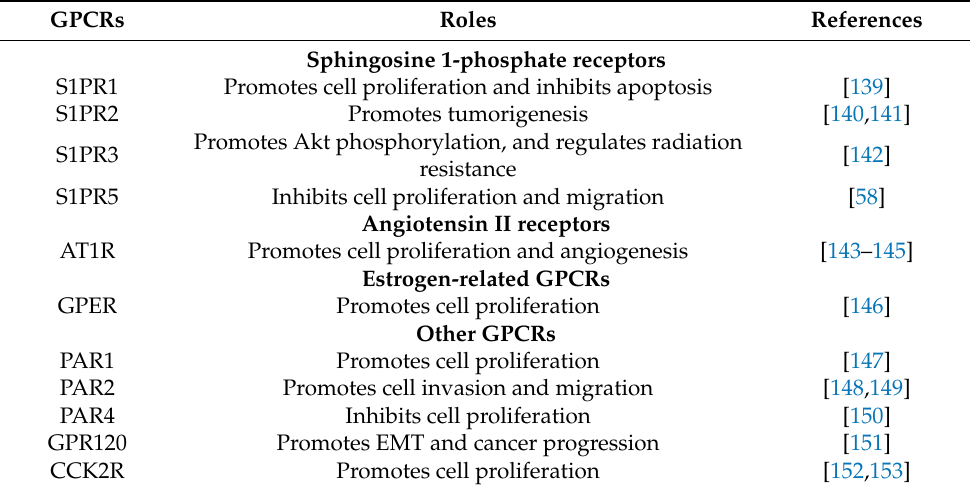
Table 3. Roles of G protein-coupled receptors in esophageal